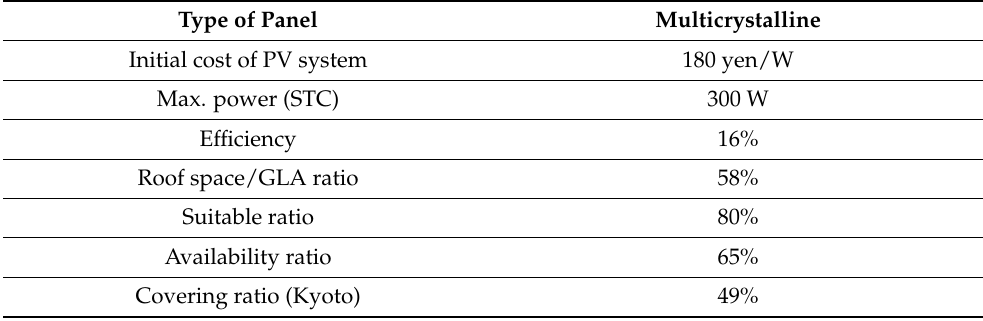
Table 4. Solar energy